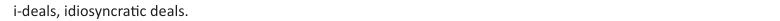
FIGURE 1: A holistic framework of the relationship between idiosyncratic deals and work